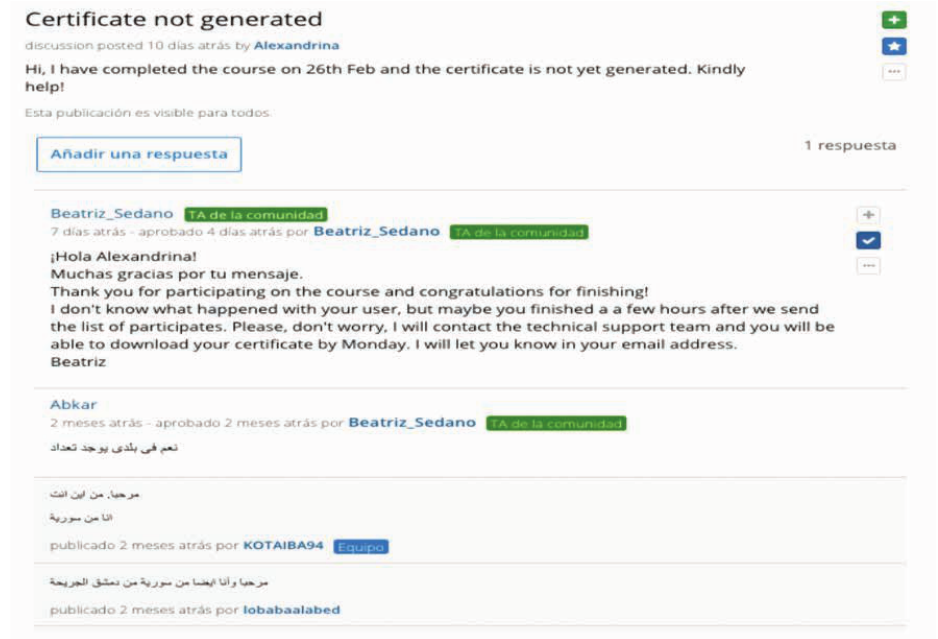
Figure 1: Example of multilingualism on LMOOC Facebook